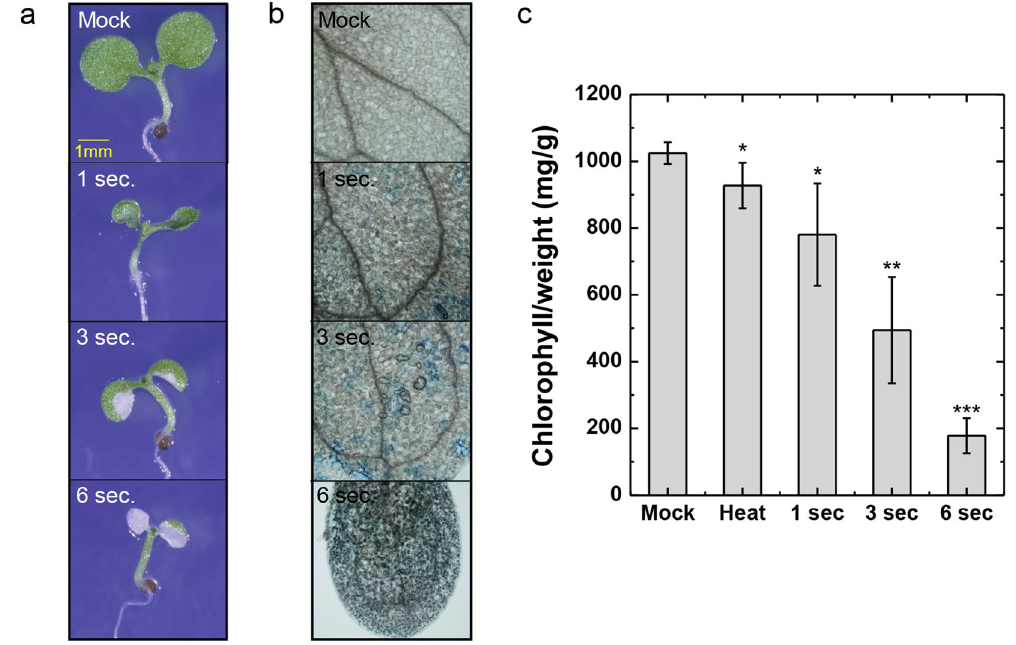
Figure 2. Arabidopsis seedlings treated with plasma on cotyledon induces cell death. ( a ) Phenotype of indicated treatment after 3 days incubation in long day condition. Scale bar = 1 mm. ( b ) Trypan blue staining of cotyledon of indicated treatment. ( c ) Total chlorophyll level of seedlings from indicated conditions. 1 sec, 3 sec, and 6 sec = plasma treatment for indicated time. Error bar = SD. Student’s t-test were used to indicate significant difference from Mock treatment, * < 0.05, ** < 0.01, *** <